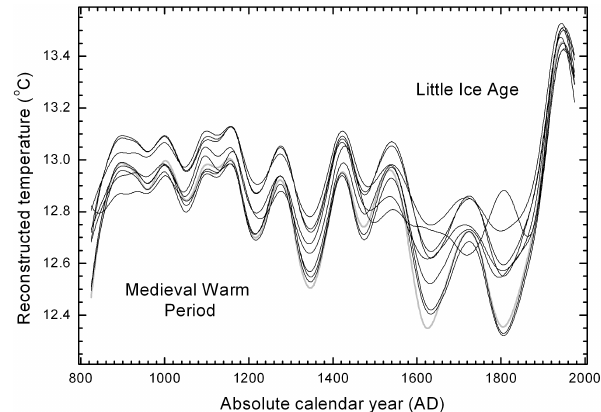
Fig. 3. Temperature reconstructions by multiple linear regression (MLR, thick grey line) and different algorithms of artificial neu- ral networks (ANN, thin black lines) over the past millennium. Records spanned the long-term climatic reversals through the Me- dieval Warm Period (occurred between AD 930 and 1180) and the Little Ice Age (occurred between AD 1601 and 1850). Series were smoothed using 150-year cubic splines (with 50 percent cutoff) in order to portray the century-scale variability and the first and last 25 years were omitted to avoid spurious end-fits. The mean of inter- series correlations for shown records was 0.95. Temperature recon- struction by scaling did not pass the verification tests and thus is not